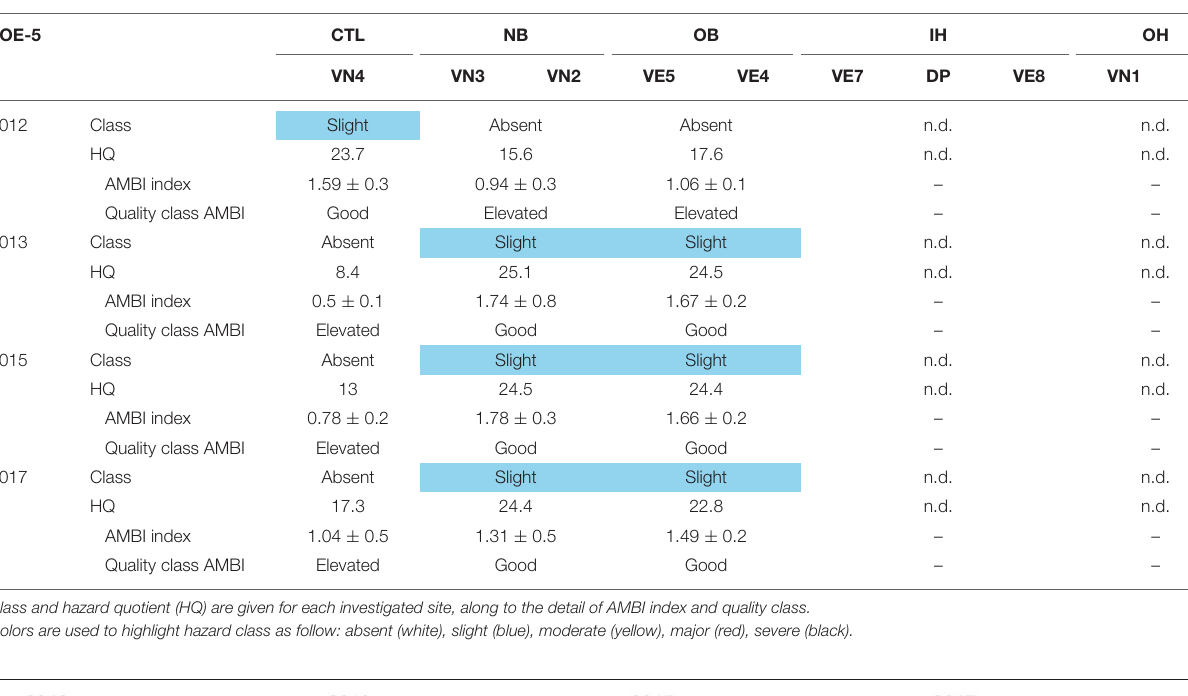
different conditions, including sites and/or sampling periods. In our study, the overall evaluation of chemicals in sediments allowed to compare across different phases of activities the hazard in sediments (LOE-1) revealed a similar trend in